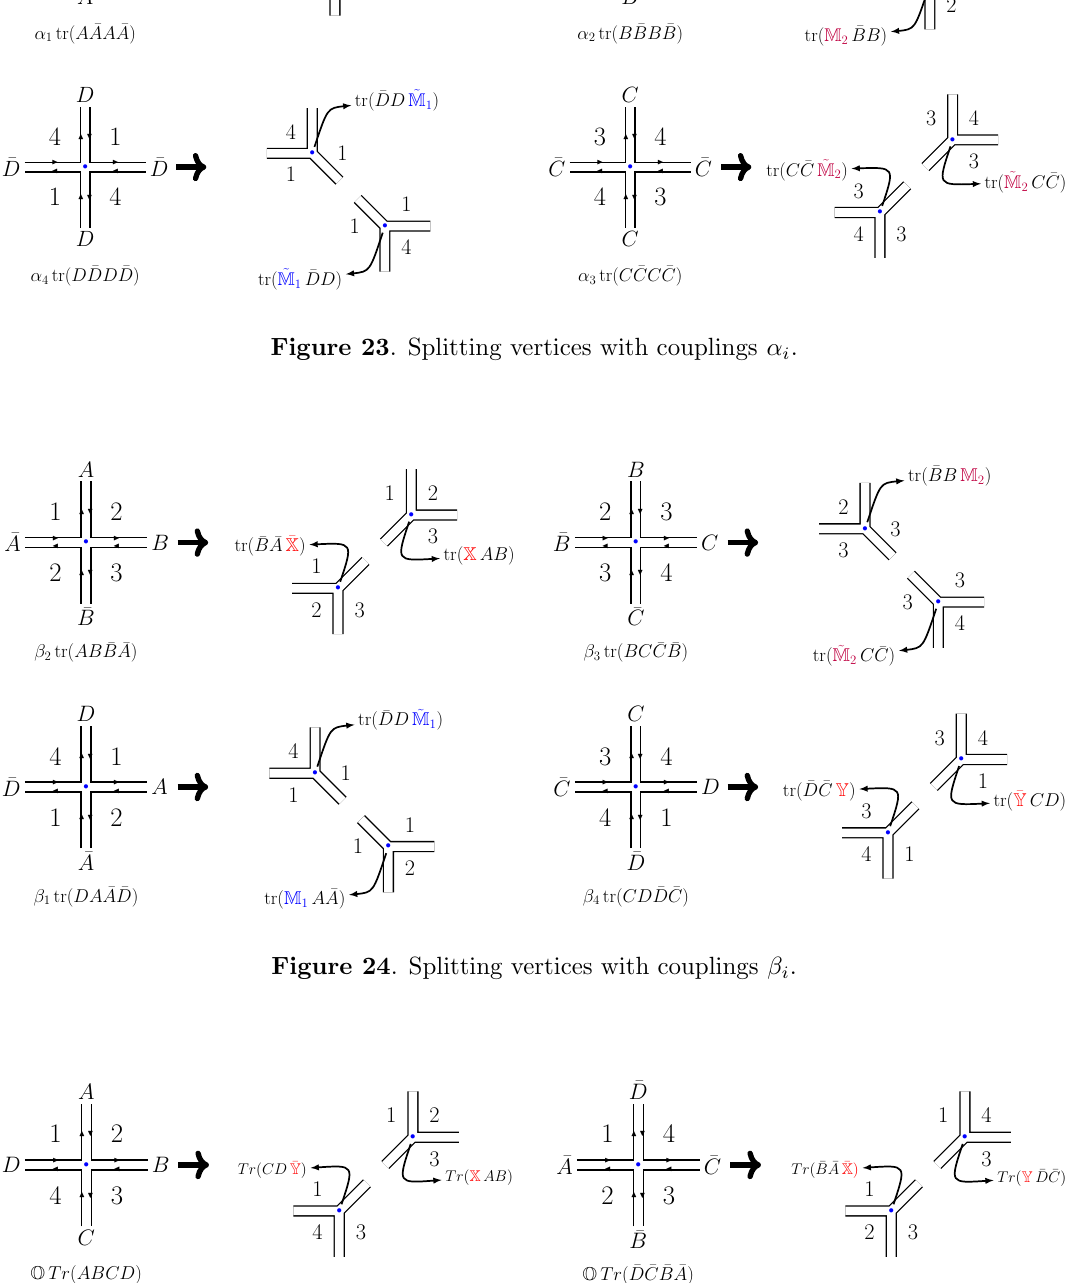
Figure 25 . Splitting vertices with coupling O using complex matrices.